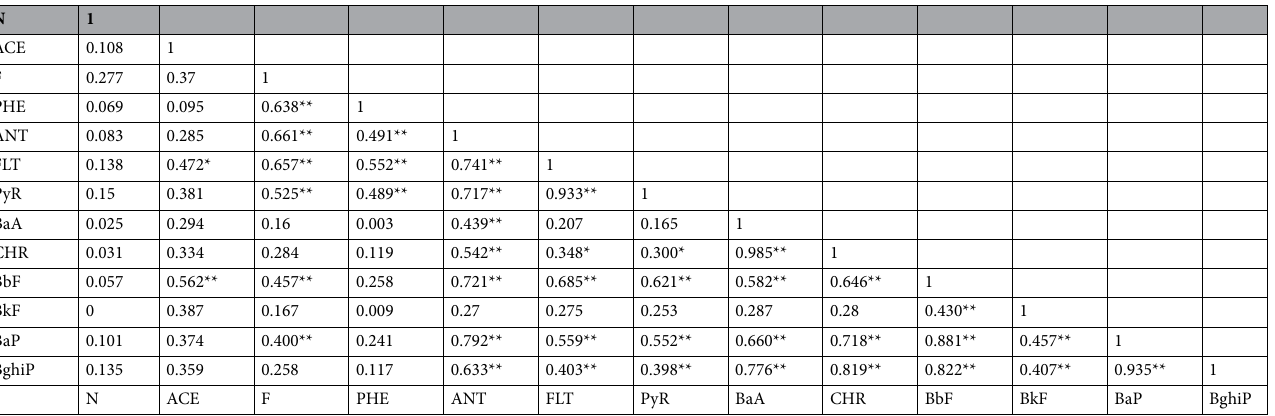
Table 1. Pearson’s correlation of individual PAH concentrations in the snow samples. *Correlation is significant at the 0.05 level (two-sided). **Correlation is significant at the 0.01 level